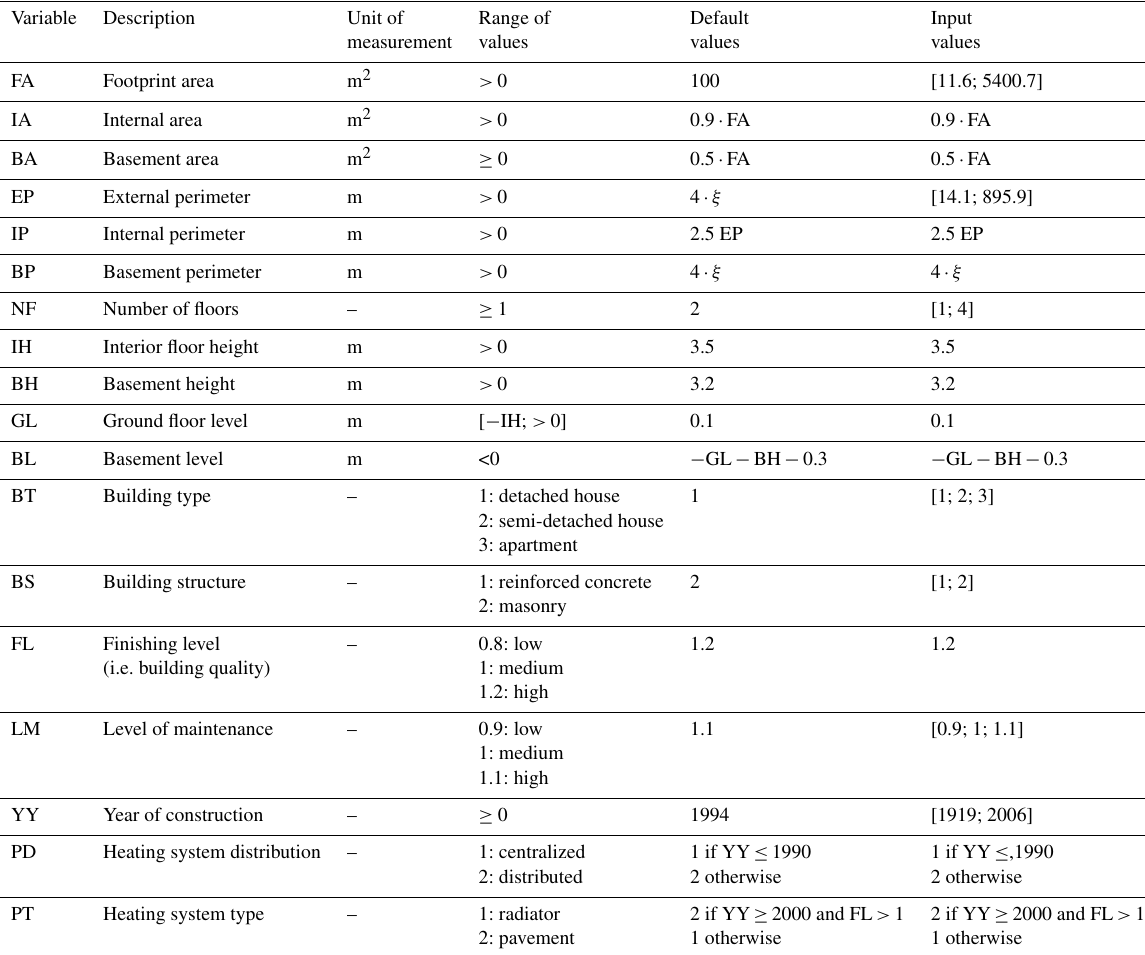
Table B2. Building characteristic parameters from the INSYDE model input